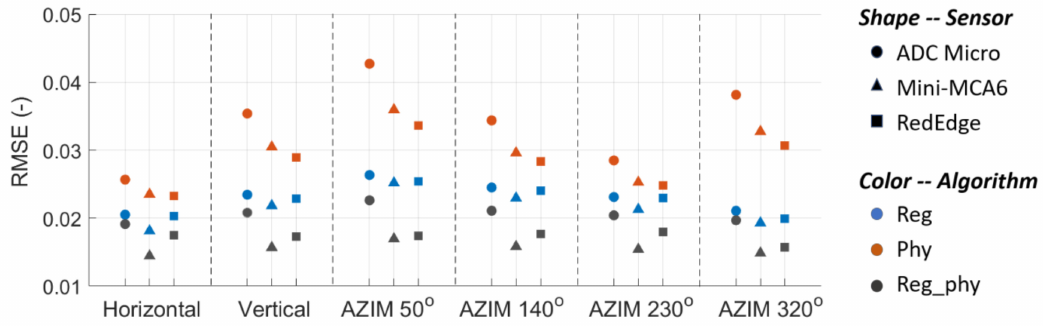
Figure 6. RMSEs of the three model-based estimated albedos with respect to the axial and orientation of target